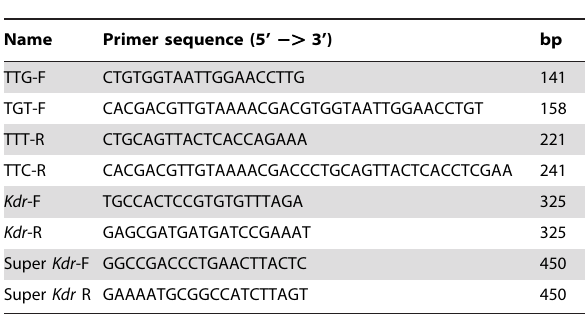
Table 1. Primer sequence of multiplex allele-specific PCR for the detection of mutations in codon 1014 of para -type sodium channel gene and super kdr mutation in codon 918 in Anopheles